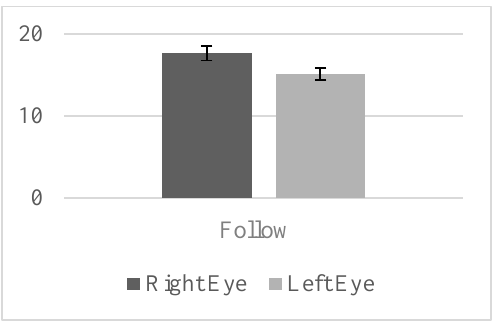
Figure 8. Left- and Right-Eye Pupil Size Differences under Right-Hand Condition for Intermediates